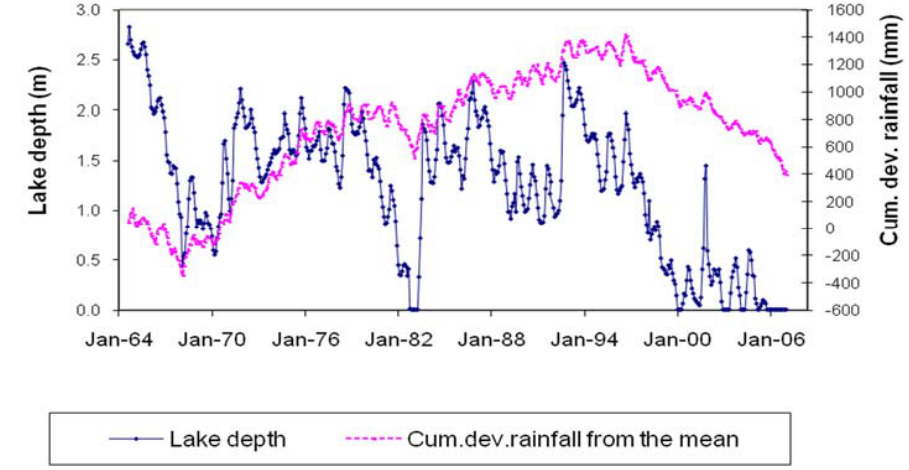
Figure 7. Lake level with variation in rainfall.